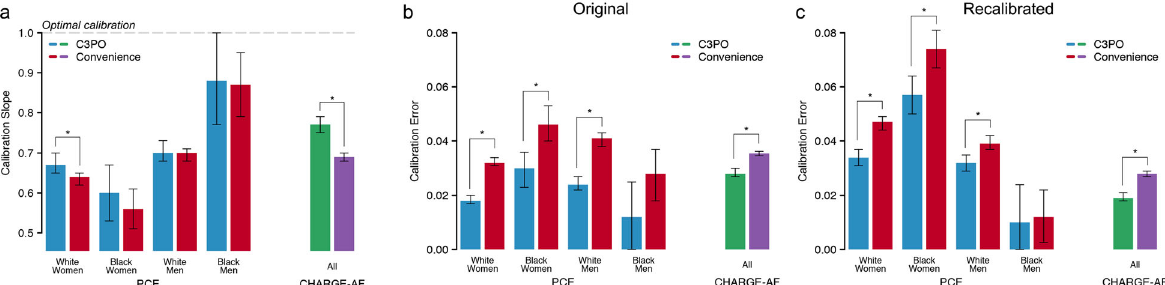
Fig. 7 Model calibration in C3PO and Convenience Samples. Depicted is model calibration performance in C3PO versus the Convenience Samples. a Depicts the calibration slope for the PCE models ( x -axis, left) and CHARGE-AF ( x -axis, right) in C3PO (blue, green) versus the Convenience Samples (red, purple). The y -axis depicts the calibration slope, a measure of the relationship between predicted event risk and observed event incidence, where a slope of one indicates an optimal relationship (horizontal hashed line), with corresponding 95% con fi dence intervals. b , c Compare calibration error in C3PO versus the Convenience Samples. Calibration error is depicted on the y -axis using the Integrated Calibration Index (ICI, see text), where lower values indicate better absolute agreement between predicted risk and observed event incidence. b Depicts ICI values using the original models, while c depicts ICI values after recalibration to the baseline hazard of each sample. In all plots, statistically signi fi cant differences between values in C3PO versus the Convenience Sample ( p < 0.05) are depicted with an asterisk.